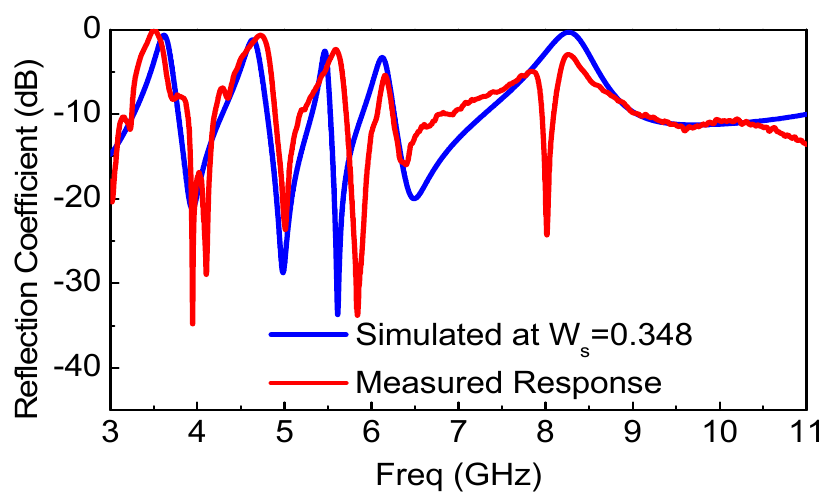
Figure 9. Simulated vs. measured frequency response of the proposed quintuple band-notched UWB antenna when W s = 0.348 mm in the simulation setup.